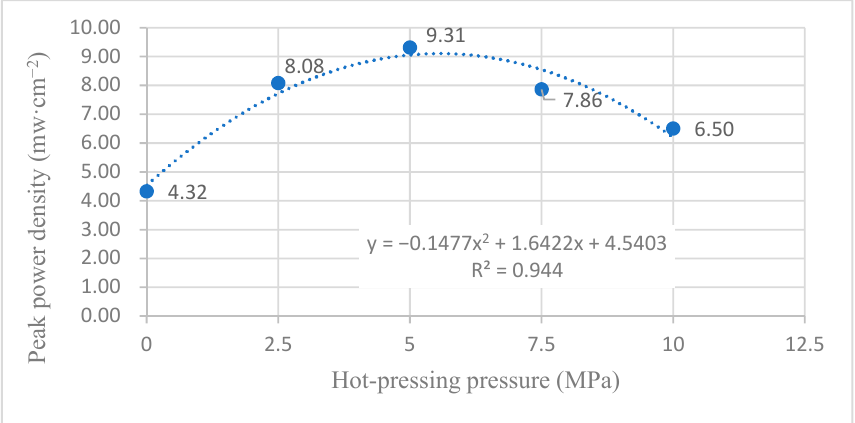
Figure 21. The fitting curve of the peak power density of MEA at different hot-pressing pressures under 60 °C and air conditions.